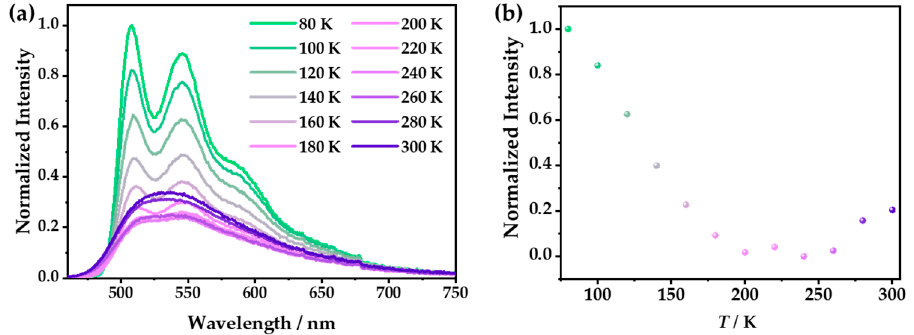
Figure 7. Under excitation at 365 nm, ( a ) the emission spectra of 1 in the temperature range from 80 to 300 K with an interval of 20 K and ( b ) the integral intensities of 1 at different